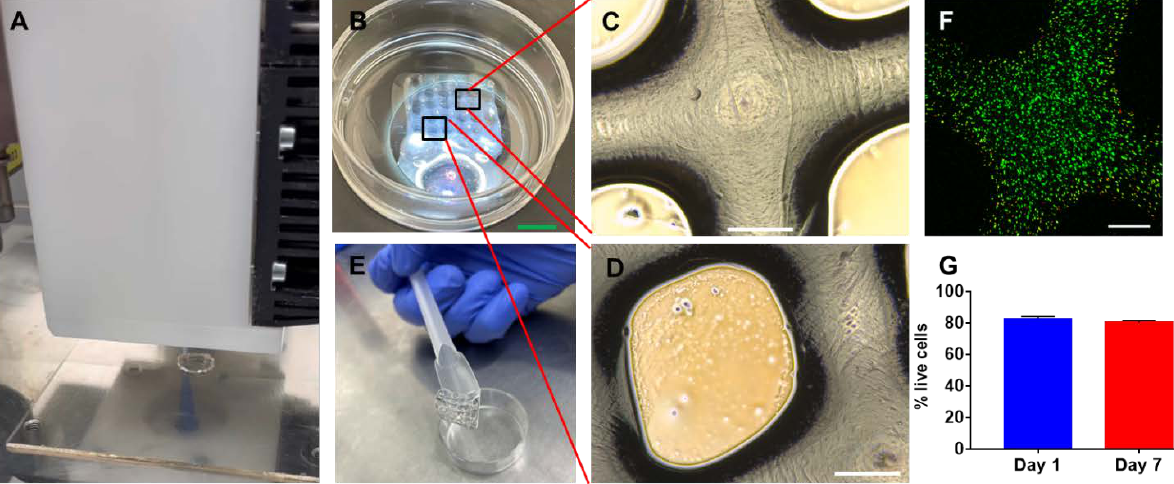
Figure 5. A 3D bioprinting study using mouse chondrocyte laden dynamic alginate hydrogels. ( A ) Illustration of extrusion based bioprinting process using dynamic hydrogel as a bioink to fabricate a cylinder shape scaffold; ( B ) top view image of a bioprinted grid scaffo ld; ( C , D ) micro-scopic image of the bioprinted scaffold with a grid structure. Black box indicates the magnified area; ( E ) repre- sentative image of a bioprinted scaffold after CaCl 2 crosslinking lifted by a spatula; ( F ) live and dead staining of mouse chon drocytes in the printed grid scaffold after printing. ( G ) Viability of the mouse chondrocyte in the printed scaffold at day 1 and day 7. Scale bar (green) = 5 mm, scale bar (white) = 500 µm.